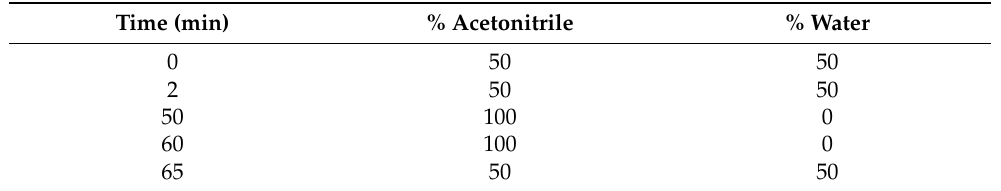
Table 2. Mobile phase gradient used in the HPLC analysis of PAHs. Time (min) % Acetonitrile % Water 0 50 50 2 50 50 100 0 60 100 0 65 50 50